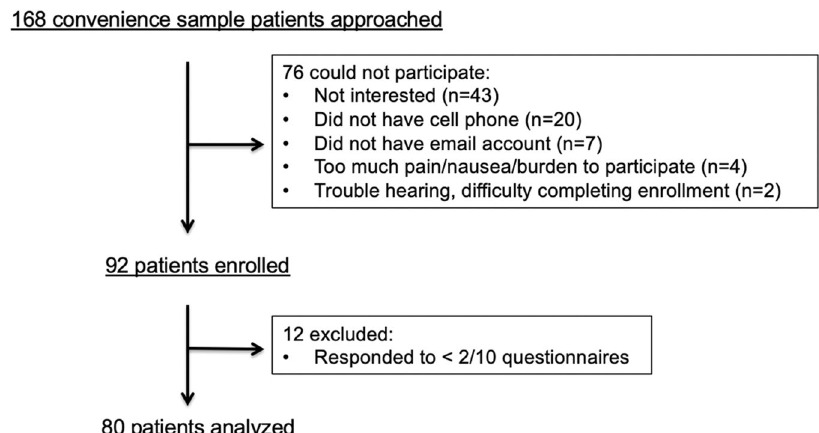
Fig. 4 CONSORT-style enrollment fl ow chart. This fi gure outlines the enrollment fl ow. Of the 92 patients enrolled, 12 were excluded due to the low response rate precluding the trajectory analysis, resulting in 80 patients analyzed for this study. There was no mortality during the follow-up